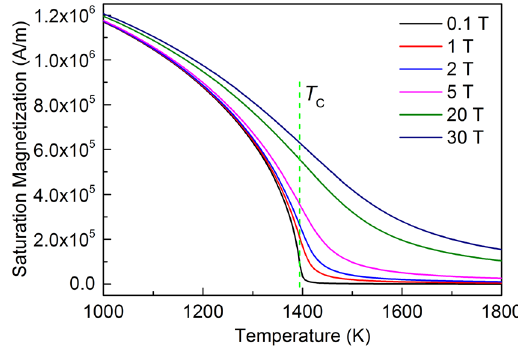
Figure 8. Saturation magnetization of Co calculated by mean field